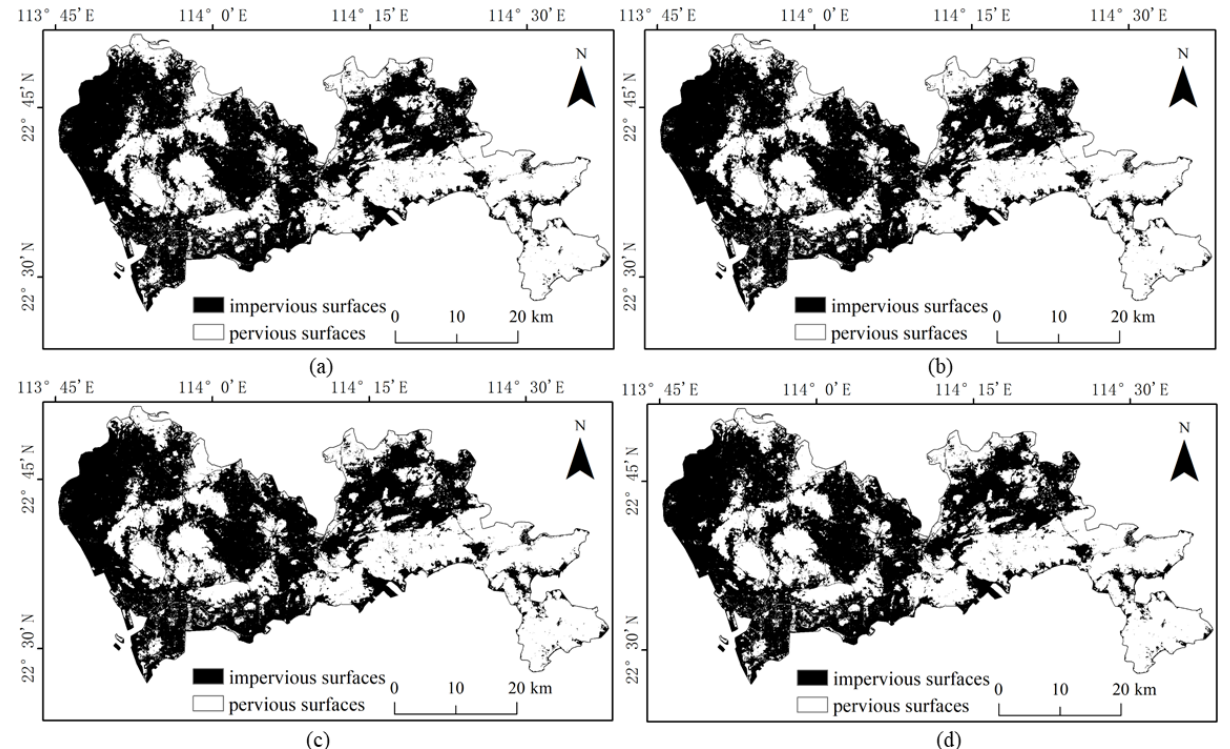
Figure 9. Results of impervious surface extraction with SVM: ( a ) 80,000 samples; ( b ) 120,000 samples; ( c ) 160,000 samples; ( d ) 200,000 samples.